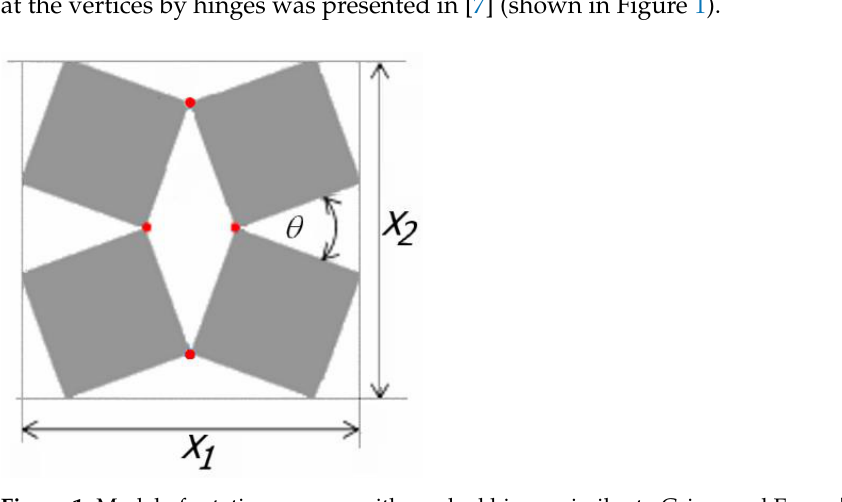
Figure 1. Model of rotating squares with marked hinges similar to Grima and Evans [7].